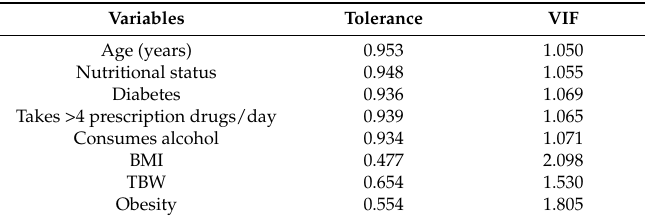
Table A1. The results of